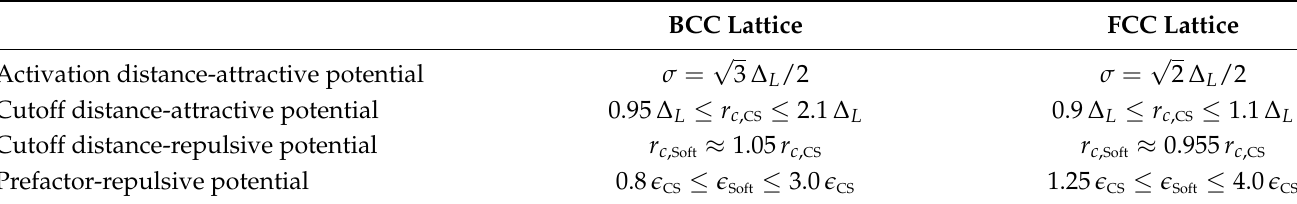
Table 1. Summary of some ranges and relationships between parameters for the elastic